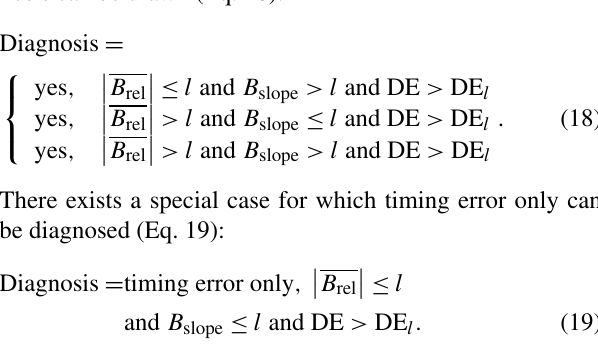
Figure 1. Observed streamflow time series from the CAMELS dataset (Addor et al., 2017; gauge id: 13331500; gauge name: Mi- nam River near Minam, OR,